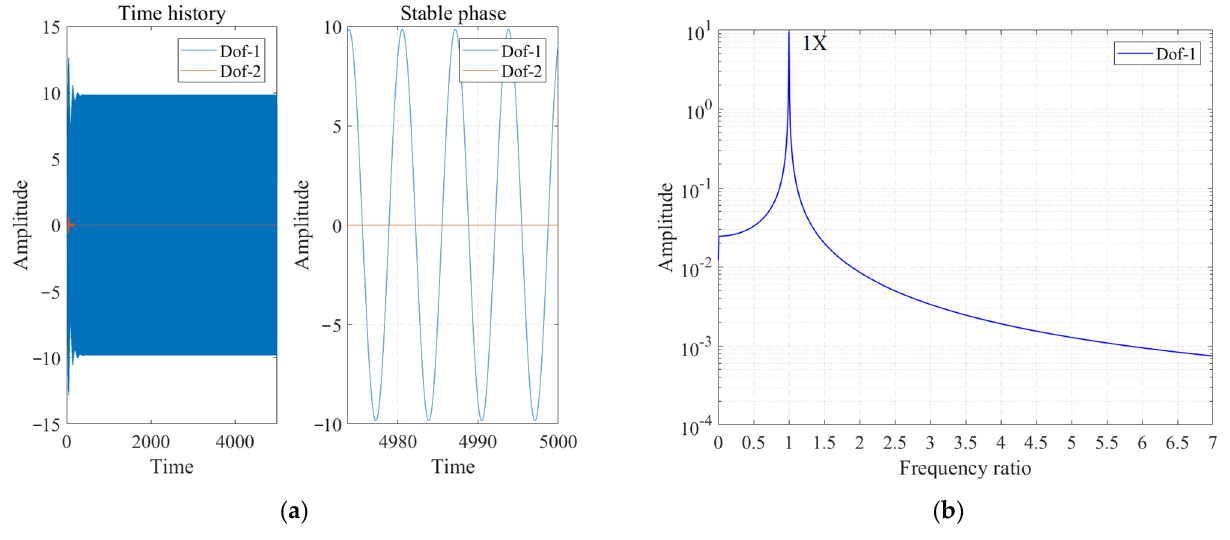
( b ) Figure 7. Amplitude–frequency characteristics, stability, and bifurcation points of the system with gap = 10: ( a ) amplitude–frequency curves; ( b ) Floquet multipliers. Based on the Ode15s solver in Matlab R17b, the initial displacement and velocity are 0 (if not specified). The time history and frequency spectra of the system at excitation fre- quencies of 0.95, 0.97, 1.02, and 1.06 are shown in Figures 8–12, where the frequency spec- tra are normalized by the excitation frequency. When the excitation frequency is located in region A, the frequency spectrum of the system includes 0.5 ω and ( ) 0.5 n ω+ , in addi- ω ; when the excitation frequency is located between